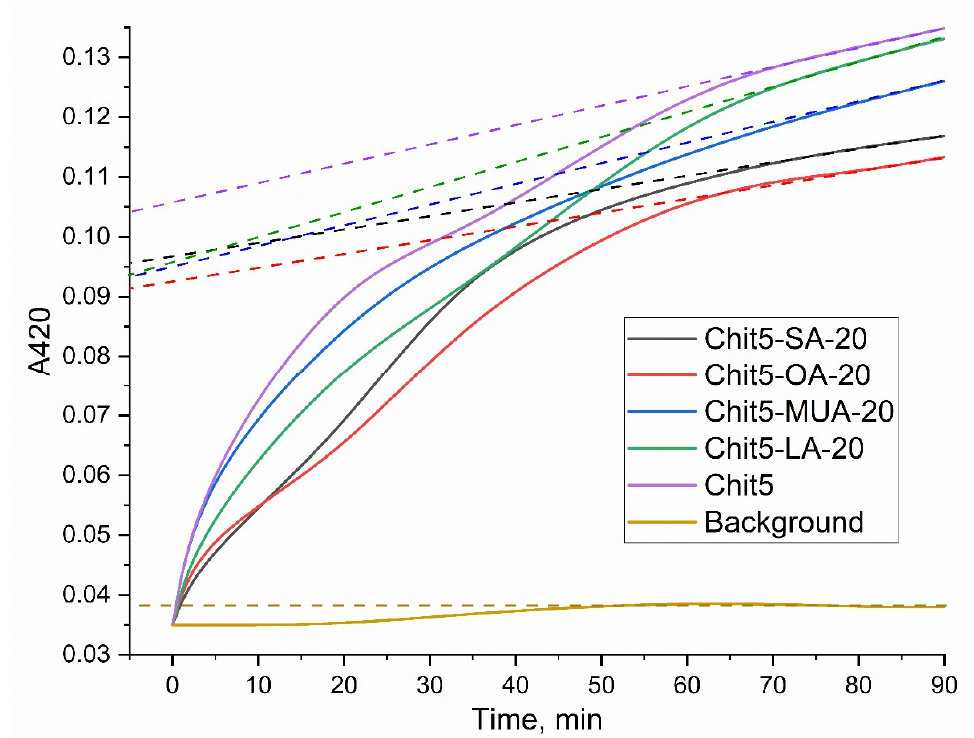
Figure 3. TNBS (2,4,6-trinitrobenzenesulfonic acid) spectrophotometric titration curves of Chit5 and its grafted derivatives. Tangents to curves (dashed lines) drawn to the ordinate axis give the value A420, from which the number of primary amino groups was calculated. T = 22 °C. 0.02 M Na 2 B 4 O 7 (pH 9.2). Table 1. Polymeric micelles’ physico-chemical characteristics.